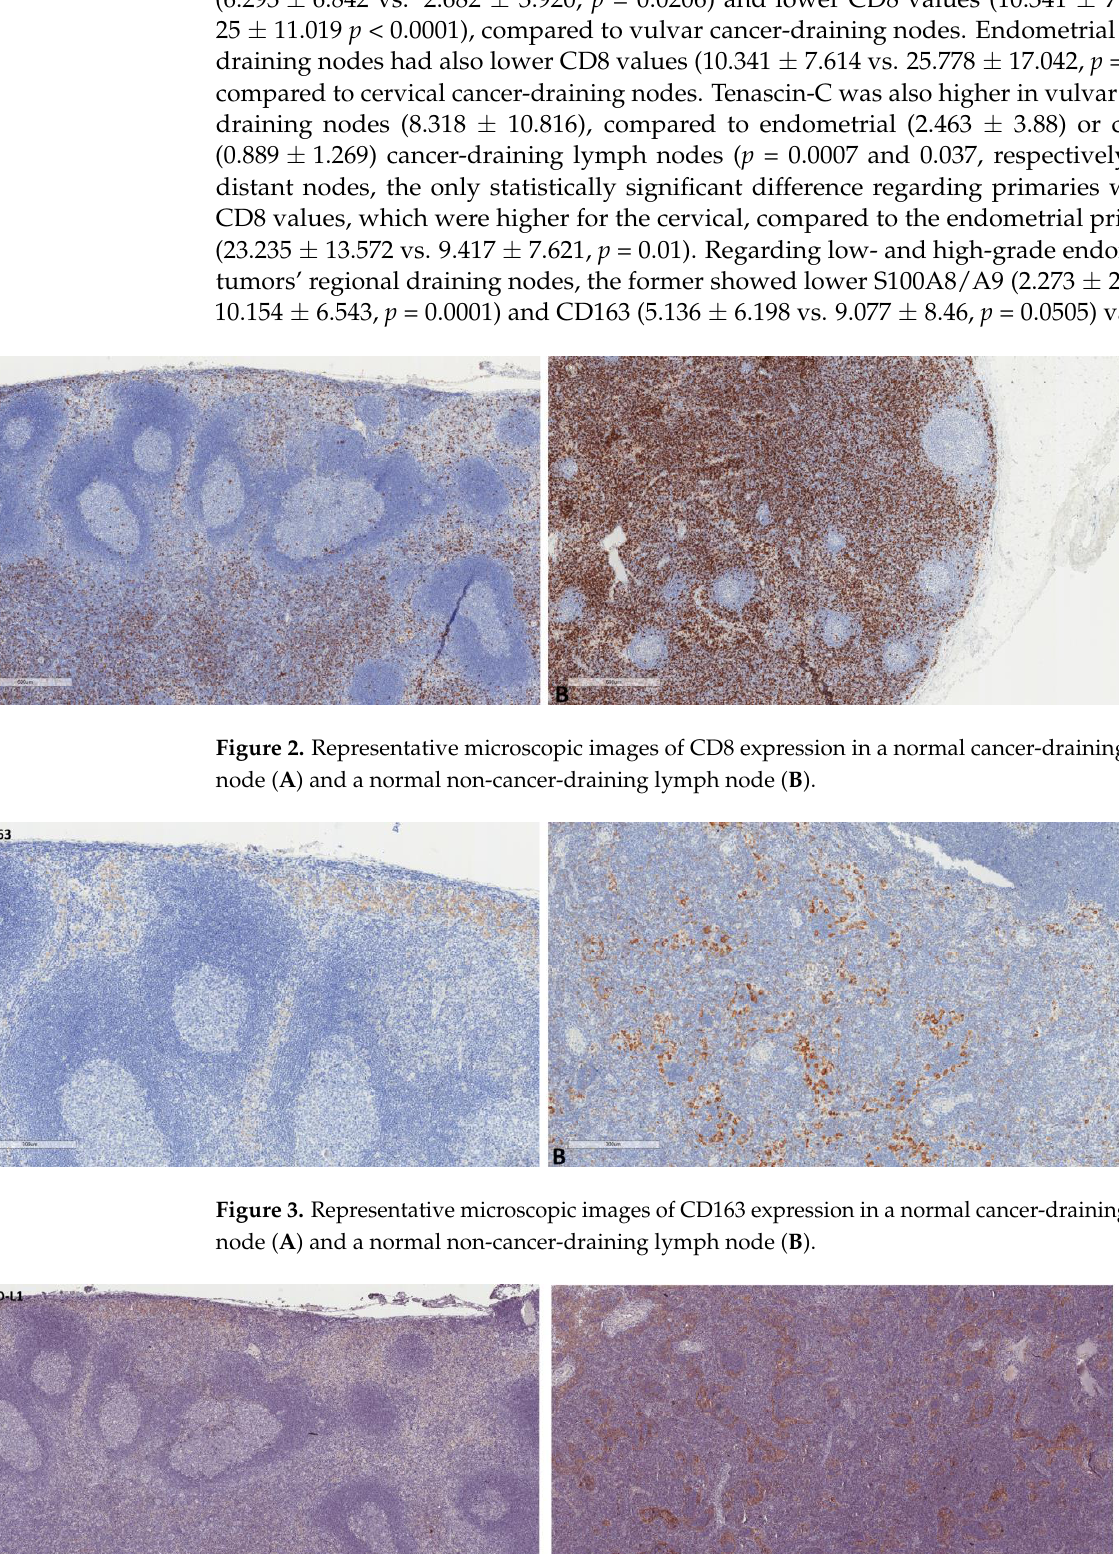
Figure 4. Representative microscopic images of PD-L1 expression in a normal cancer-draining lymph node ( A ) and a normal non-cancer-draining lymph node ( B ).